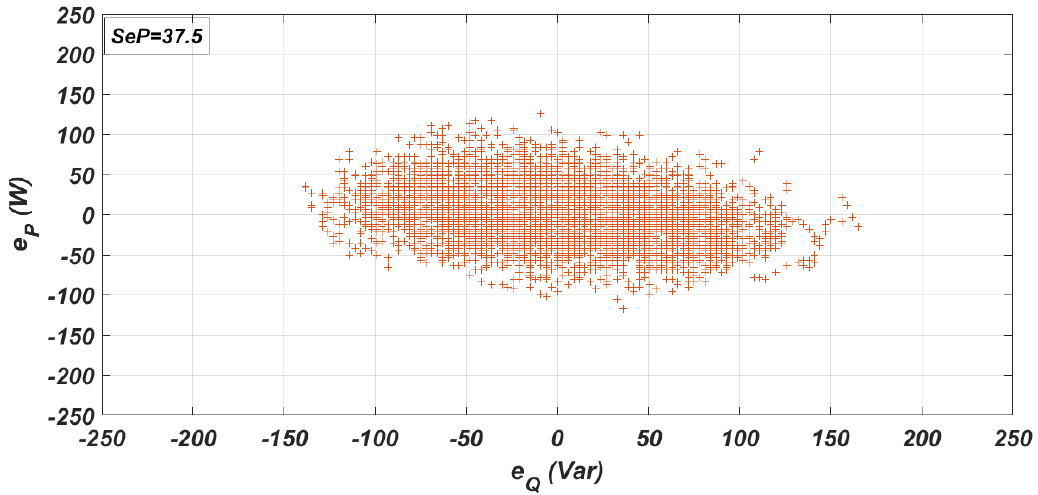
Figure 10. Plot of [ e Q ( t ), e P ( t )] pairs used for the calculation of SeP for the properly configured PTMVR method.